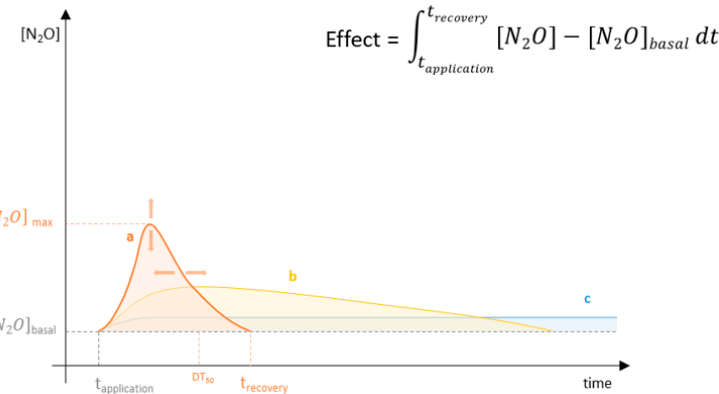
Figure 1. Representation of the monitoring over a long-time period of three hypothetical greenhouse gas emission profiles associated to different stress events (a, b and c). As represented with the arrows on the event ‘a’, environmental conditions and soil properties can modify the effect of agrochemicals on microbial communities’ functions and their recovery time. The short-term assessment of each of these events may detect the acute effect on the emission of greenhouse gasses ([N 2 O] max ) but would not be able to predict the environmental impact of the events. The event ‘a’ and ‘b’ can have a similar environmental impact in spite of ‘a’ having a considerably higher short time impact but a faster recovery to basal emission levels. Conversely, the event ‘c’ is characterised by a lower environmental impact in the short but also long timeframe. This event would likely require an anthropogenic intervention to restore the basal level of greenhouse gas emission.